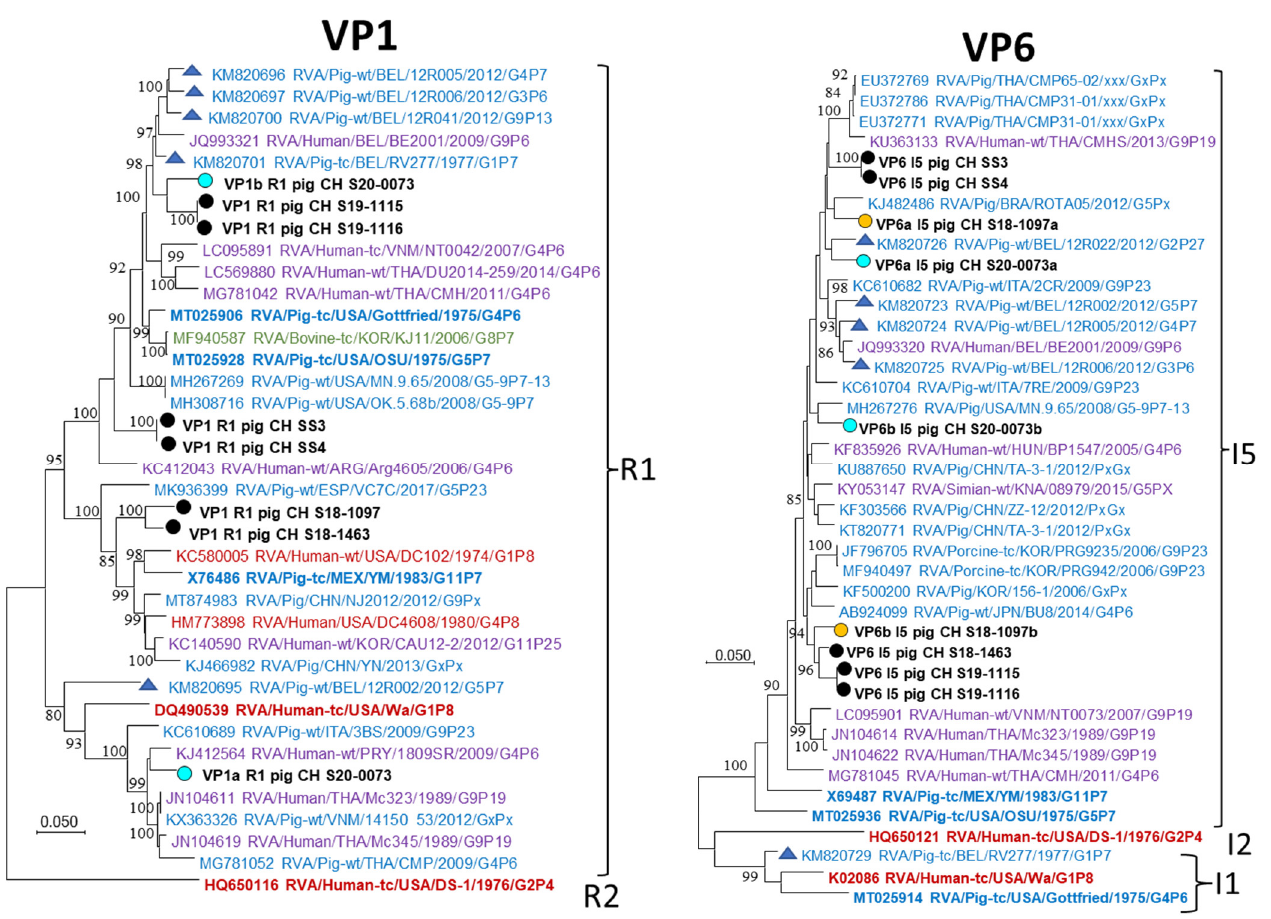
Figure 6. Maximum likelihood phylogenetic trees of the CDS of VP1 and VP6 sequences. RVA strains from this study are highlighted with circles, and names are written in bold black letters. Circle fill-colors blue and yellow indicate the common origin of co-infecting sequences. Letters after the protein ID of the Swiss strains (e.g., VP1a and VP1b) indicate multiple sequences for the CDS of this segment. The reference strains included in Table 1 are highlighted in bold, and Belgian references with triangles. A legend of the color codes of the strain names is provided in Figure 5.